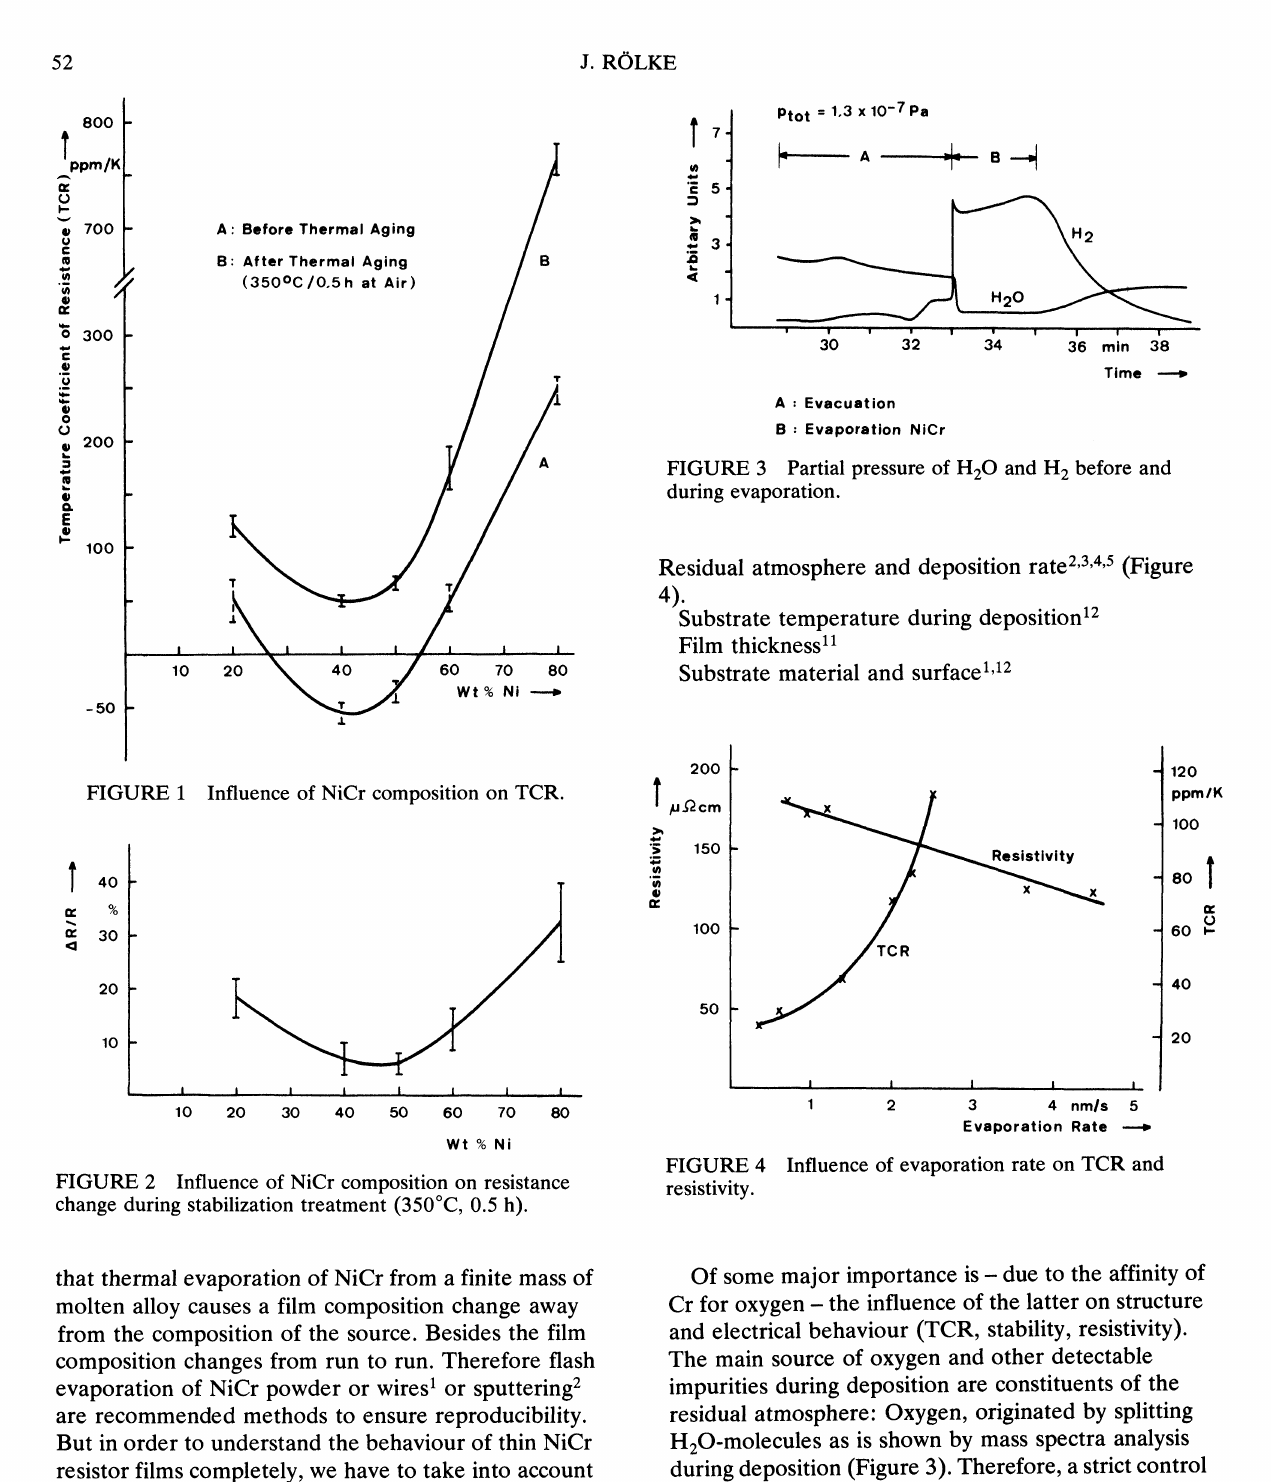
FIGURE 2 Influence of NiCr composition on resistance change during stabilization treatment (350C, 0.5 h).